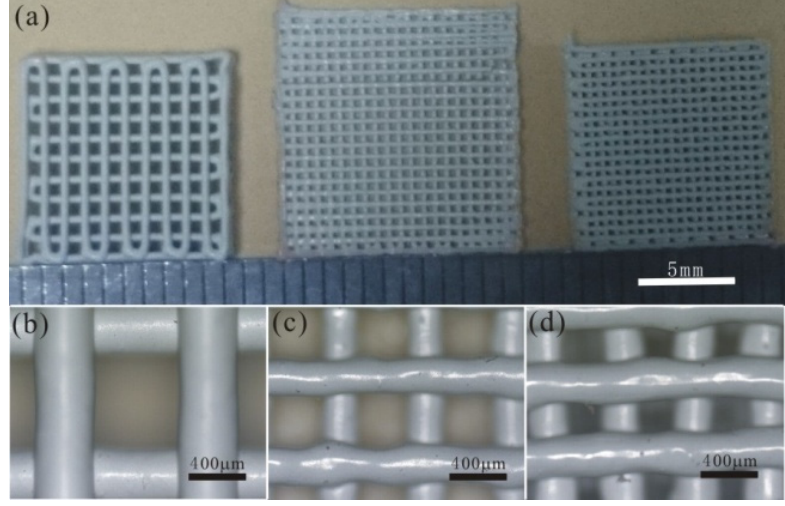
Figure 4. Optical images of the woodpile structures: ( a ) top view of three samples with different sizes; ( b ) 10 mm × 10 mm sample with a filament diameter of 400 μ m; ( c ) 12 mm × 12 mm sample with a filament diameter of 250 μ m; ( d ) 10 mm × 10 mm sample with filament a diameter of 300 μ m.